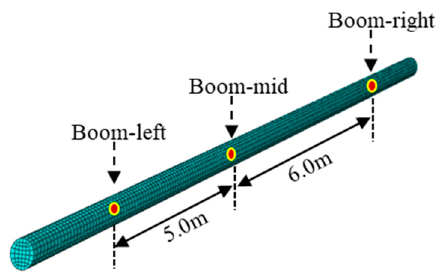
Figure 3. Deflagration positions.